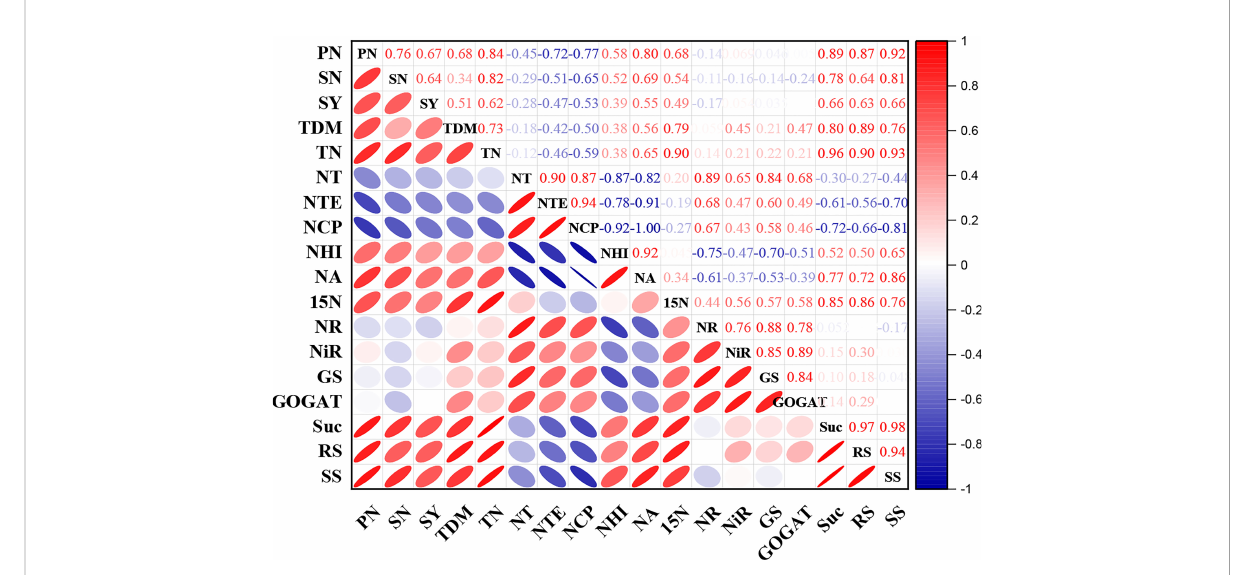
FIGURE 7 Correlation analysis between agronomic traits, nitrogen content, carbohydrates and yield. Red and blue color represents the positive and negative correlation. The size and intensity of color exhibited the signi fi cance of variables. PN, pod number; SN, seed number; SY, seed yield; TDM, total dry matter, TN, total nitrogen; NT, nitrogen translocation, NTE, nitrogen translocation ef fi ciency; NCP, nitrogen contribution proportion; NHI, nitrogen harvest index; NA, nitrogen assimilation; 15N, 15 nitrogen isotope; NR, nitrate reductase; NiR, nitrite reductase; GS, glutamine synthetase; GOGAT, glutamate synthase; Suc, sucrose; RS, reducing sugar and SS, soluble